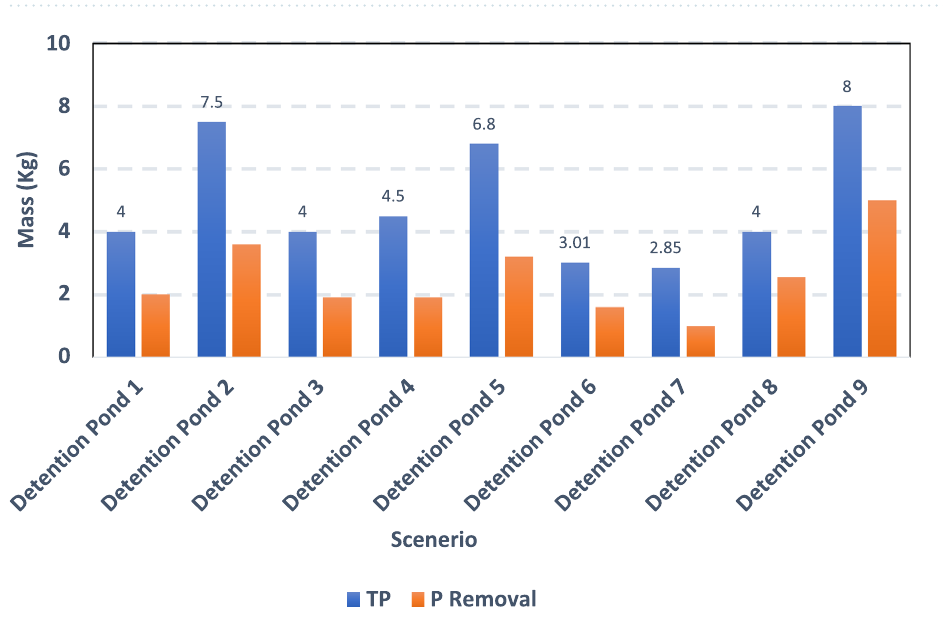
Figure 15. Removal (in kg) of total phosphorite (TP) and phosphorite (P) for different scenarios of detention